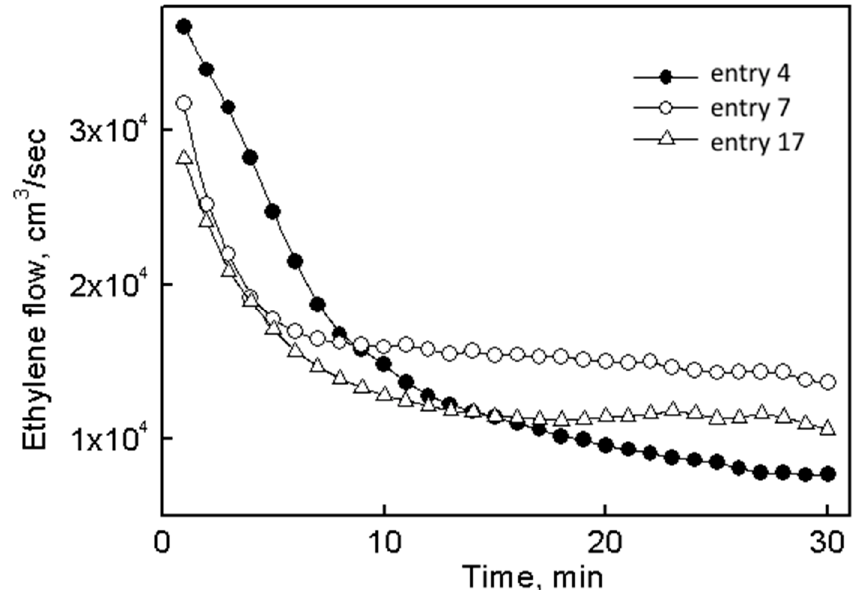
Figure 3. Kinetic dependence of catalytic systems based on catalytic systems I (entry 4), II (entry 7) and III (entry 17).